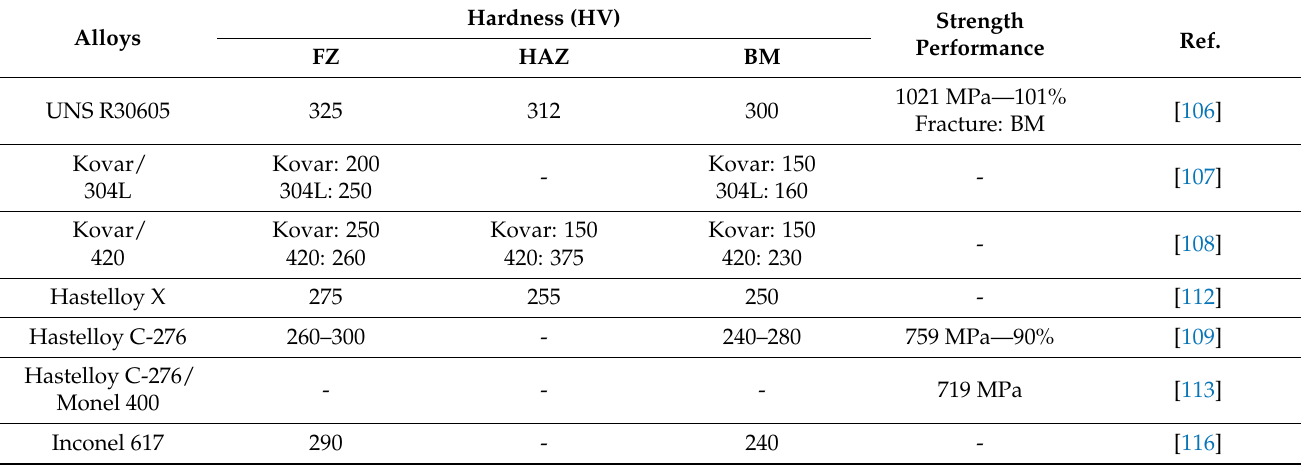
Table 9. Selected results of pulsed laser welding apply to superalloys (approximated values).